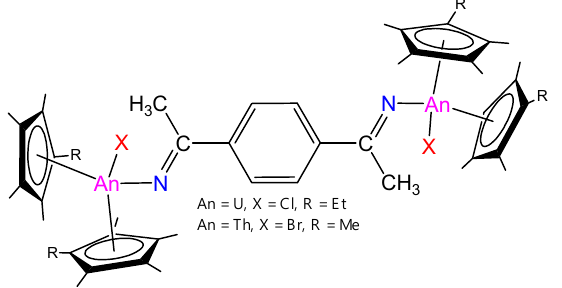
Figure 2. Structure of the bis(ketimide)-bridged [(C 5 Me 4 Et) 2 (Cl)An] 2 (µ-{N=CMe-(C 6 H 4 )-MeC=N}) binuclear An IV /An IV (Th, U) complexes (ketimide = 1,4-phenylenediketimide) [128].